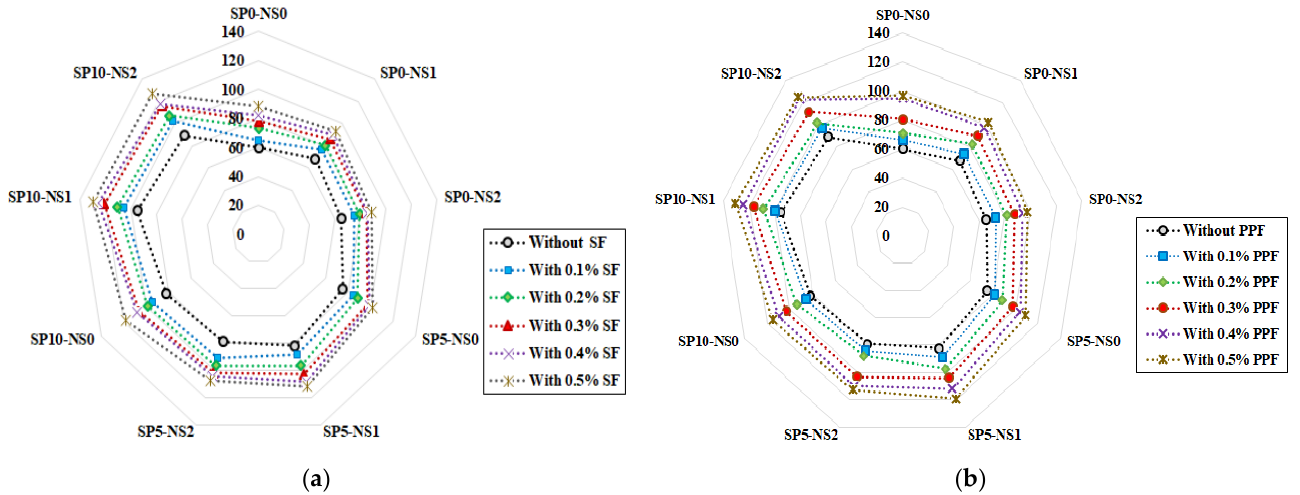
Figure 9. Impact of the fibres on the compressive strength of HSC containing NS and SP ( a ) SF and ( b ) PPF.